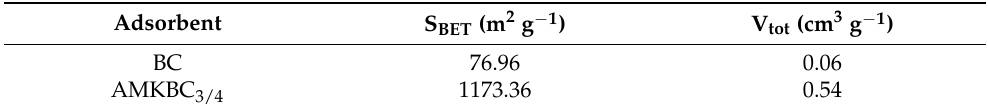
Figure 4. N 2 adsorption-desorption isotherms ( a ), and pore size distribution ( b ) of BC and AMKBC 3/4 . Table 1. The textural parameters of BC and AMKBC 3/4 .